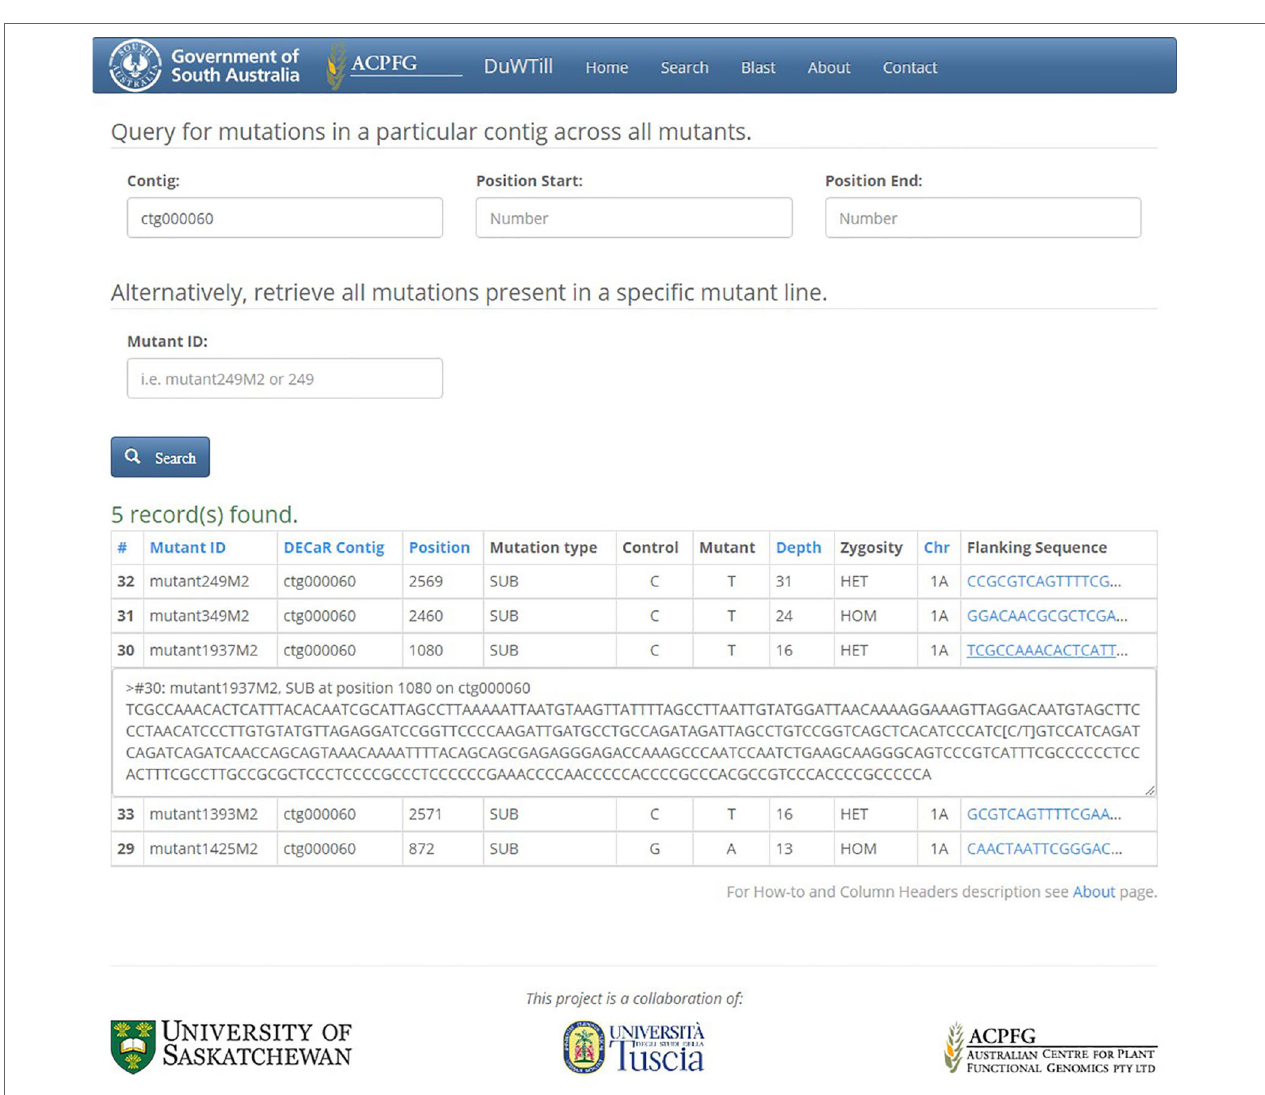
FIGURE 3 | Search page showing results of query in DuWTill by contig ID. Output table, sorted by depth, displays all mutations within DECaR contig ctg000060 detected across the mutants. Third row (mutant1937M2) is expanded to show the full flanking sequence in FASTA